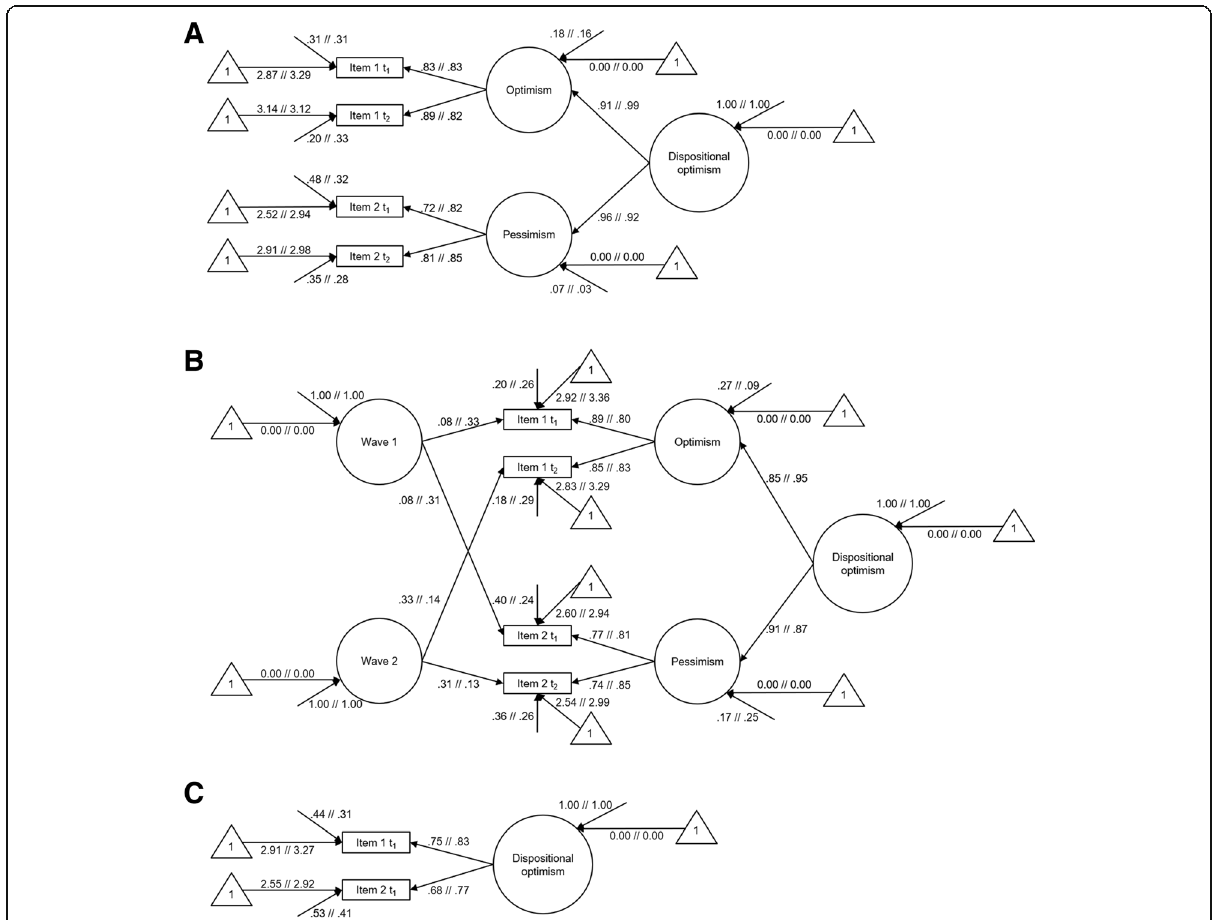
Fig. 1 Measurement models of SOP2 with standardized coefficients and equalized factor loadings. The negatively worded item is reverse-scored. The coefficients of the German sample are presented after the double slash. N UK = 468, N DE = 474. A: Hierarchical two-factor measurement model. B : Hierarchical two-factor measurement model with wave-specific method factors. C: Unidimensional measurement